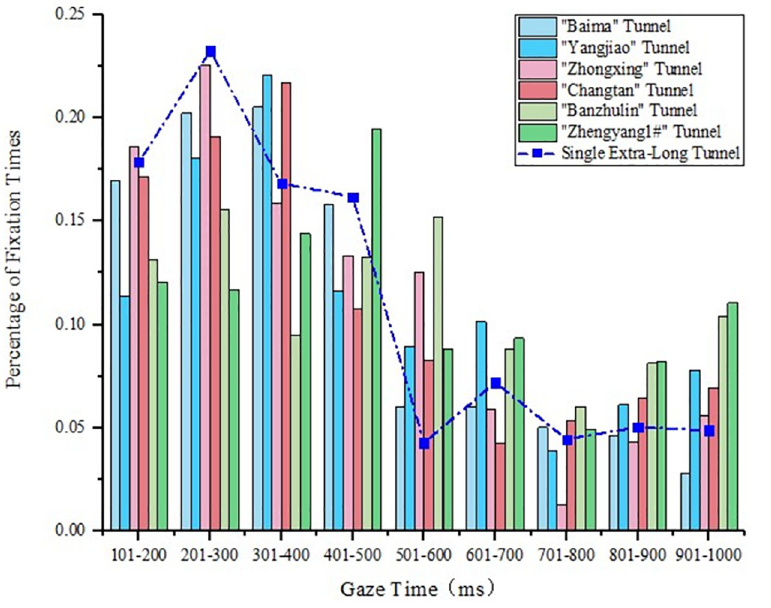
Fig 6. Statistical diagram of the gaze time of the extra-long tunnels in the tunnel